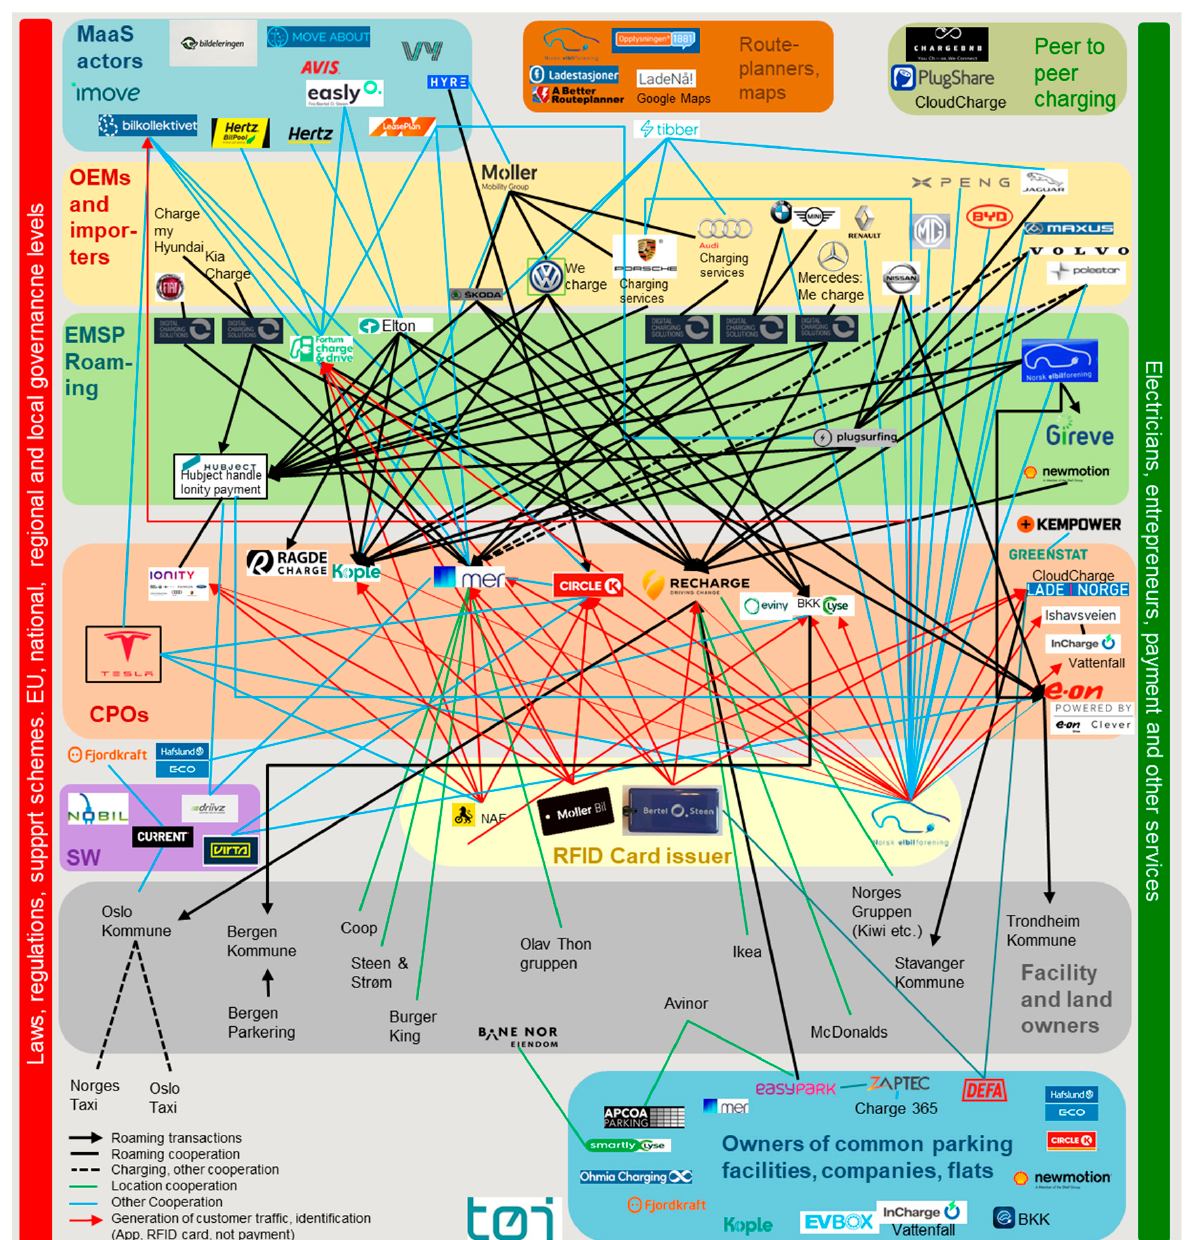
Figure 5. The Norwegian charging infrastructure ecosystem. Roaming transactions: thick black line with arrow; roaming co-operation: thick black line; other charging co-operation: stippled thick black line; location co-operation: green line; other co-operation: blue line; generation of customer traffic by co-operation on customer identification (RFID card issuers, etc.): red line with arrow. Source: the authors.